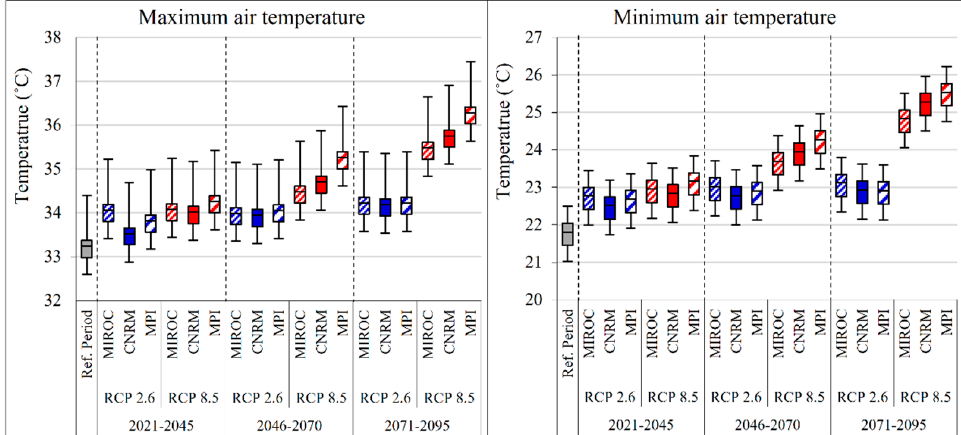
Figure 4. Monthly maximum and minimum air temperatures in the reference period (1981–2005) with the near future, intermediate future, and far future under RCP 2.6 and RCP 8.5.